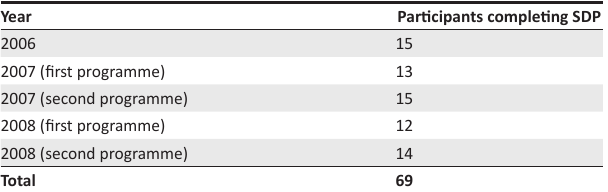
TABLE 1: Participants completing supervisory development programmes between 2006 and